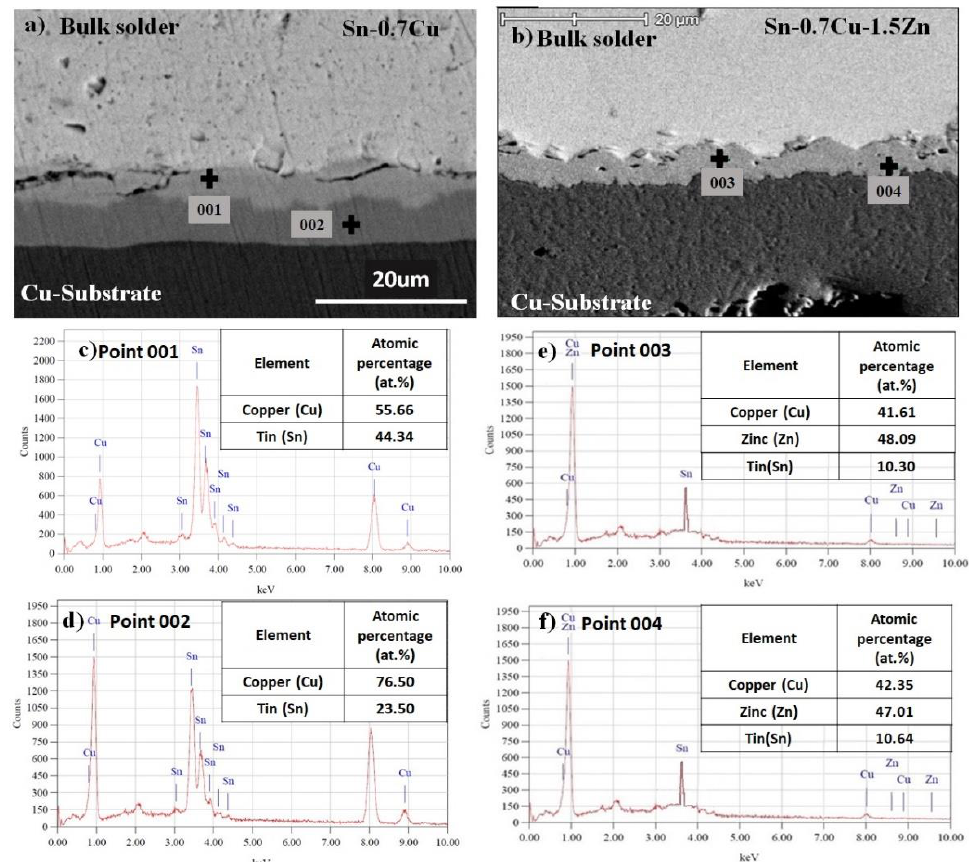
Figure 6. EDX point analysis at interfacial IMC of ( a ) Sn-0.7Cu alloys and ( b ) Sn-0.7Cu-1.5Zn alloy after annealing at 180 °C for 240 h. ( c ): Cu 6 Sn 5 ( d ): Cu 3 Sn ( e) Cu-Zn ( f ) Cu-Zn.